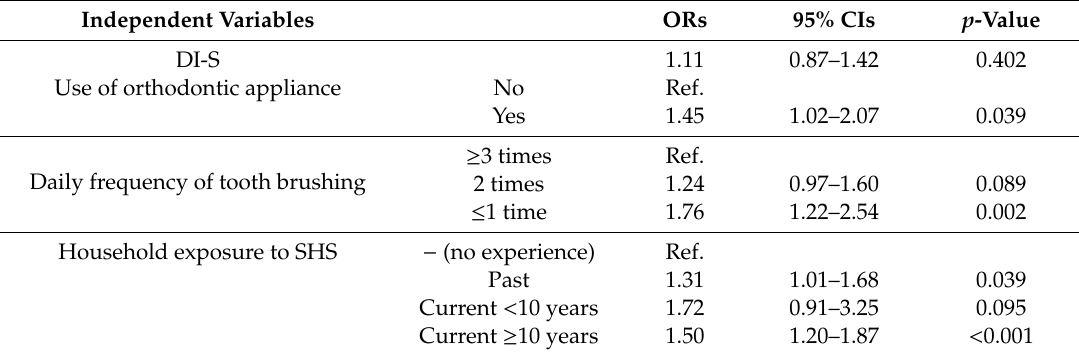
Table 3. Logistic regression analysis when independent variables were selected based on the p -value ( < 0.20) by the chi-square test or Mann–Whitney U